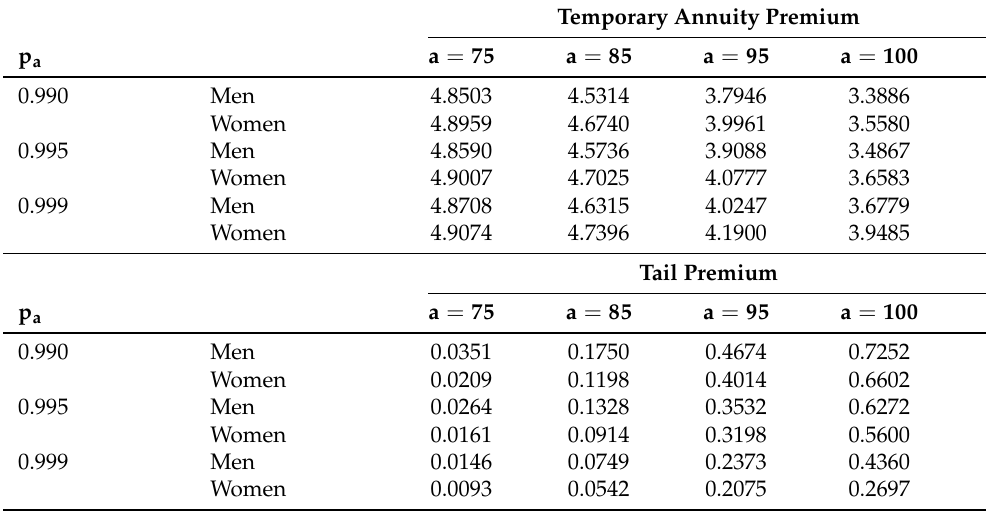
Table A6. Temporary annuity premium assuming w = CQ p for r = 0.2 and year 2017. The probabilities t P a were estimated with the Beta Transformed Kernel Estimator